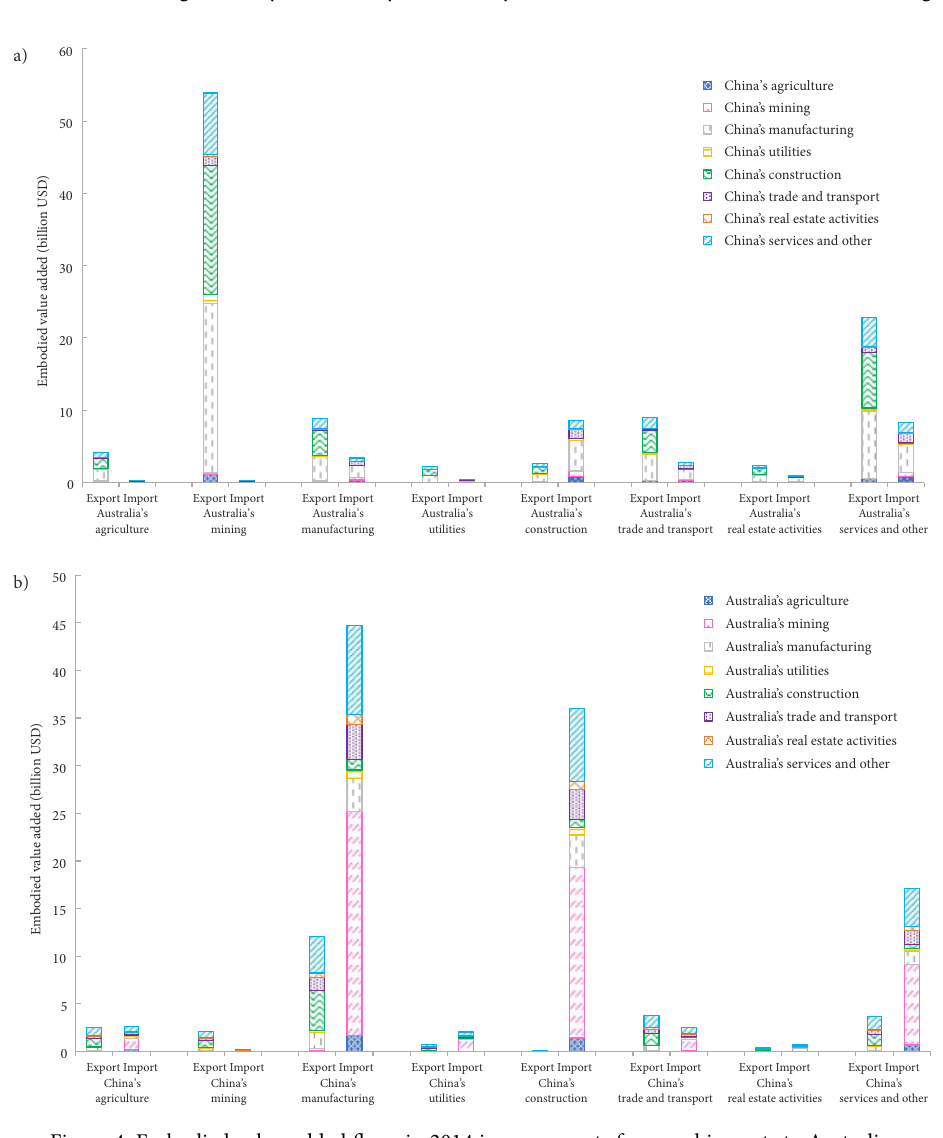
Figure 4. Embodied value-added flows in 2014 in: a – exports from and imports to Australia; b – exports from and imports to